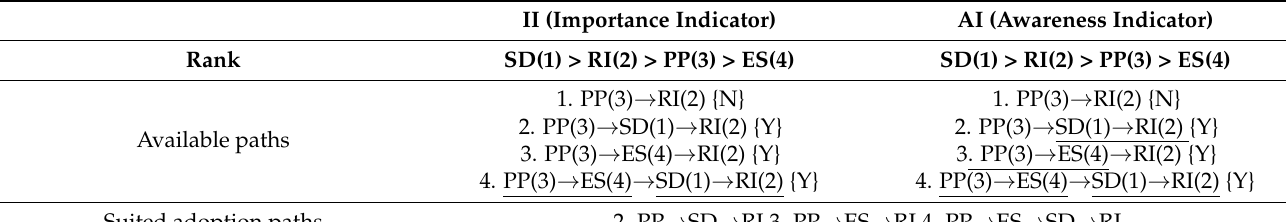
Table 9. The suited adoption paths of SDM competency development for medical residents.